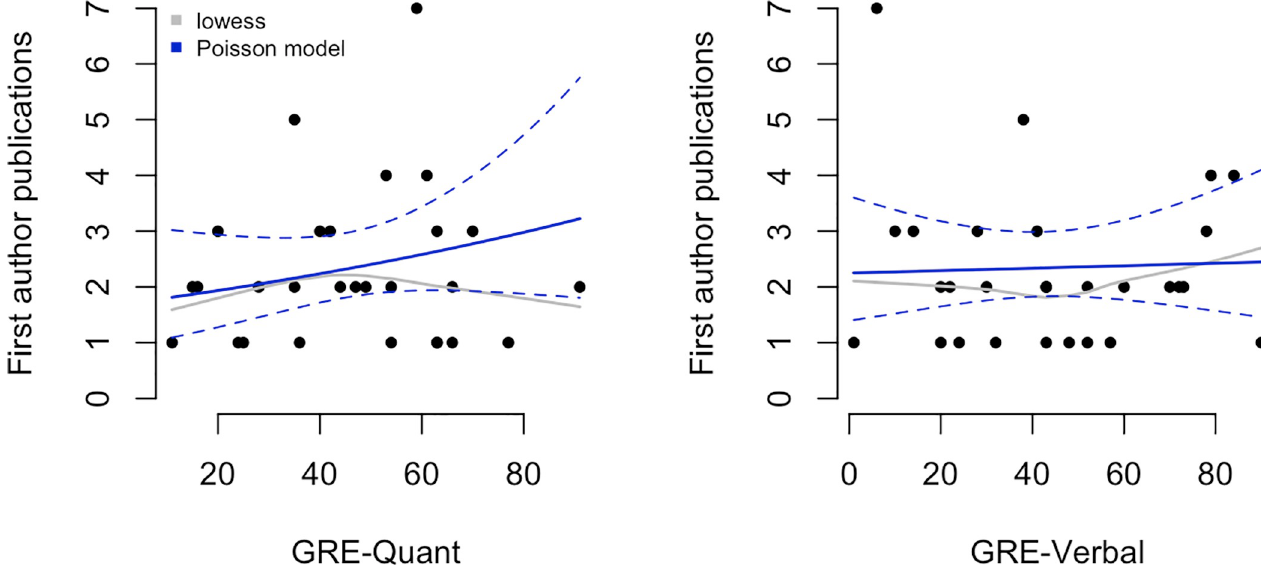
Fig 4. Associations between quantitative and verbal GRE scores and total number of first author publications. Solid curves show the fitted values from the Poisson regression models (dashed lines are 95% confidence intervals) and the grey curves show lowess smoothers (locally weighted scatterplot smoother).